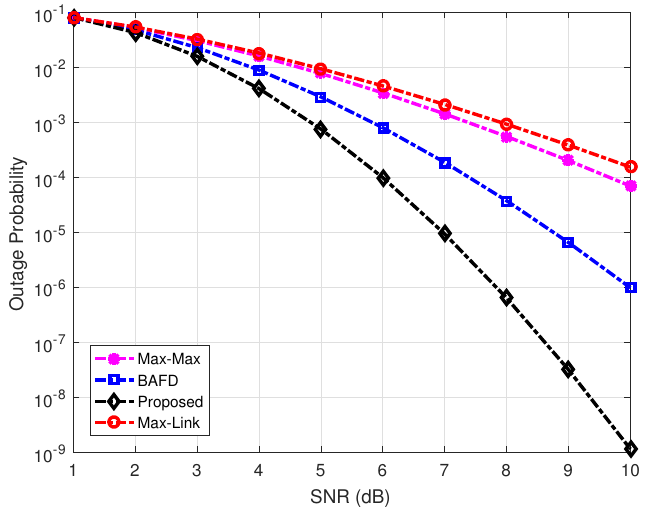
Figure 15. Outage probability vs. SNR.